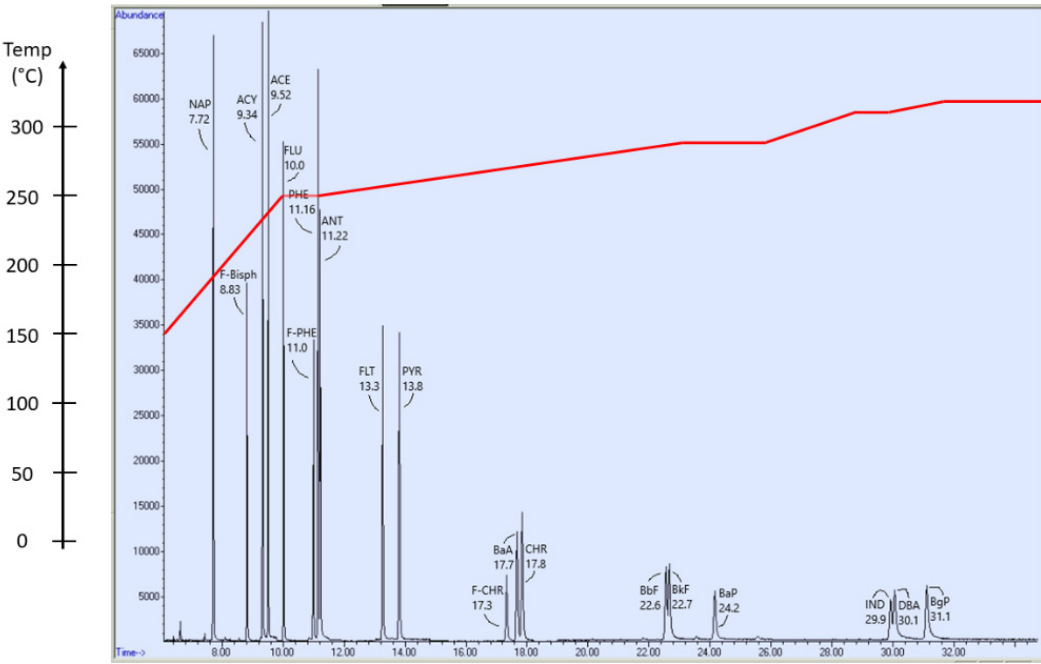
Figure 4. GC-MS chromatogram presenting the elution order of the 16 PAH target analytes. The sample was a calibration standard sample with a concentration of 100 µg/L of each PAH target analyte. The elution temperature gradient is presented superimposed on the chromatogram (red line). The oven gradient temperatures are listed in the Supplementary Information (Table S3).